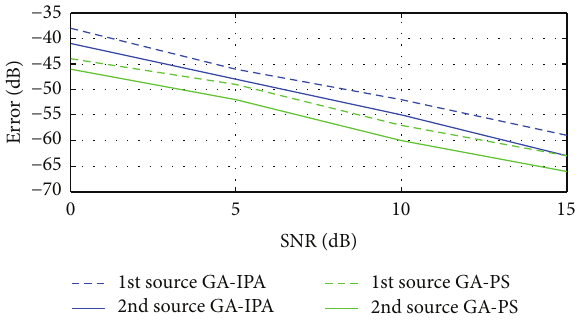
Figure 9: Error estimation of the amplitudes versus